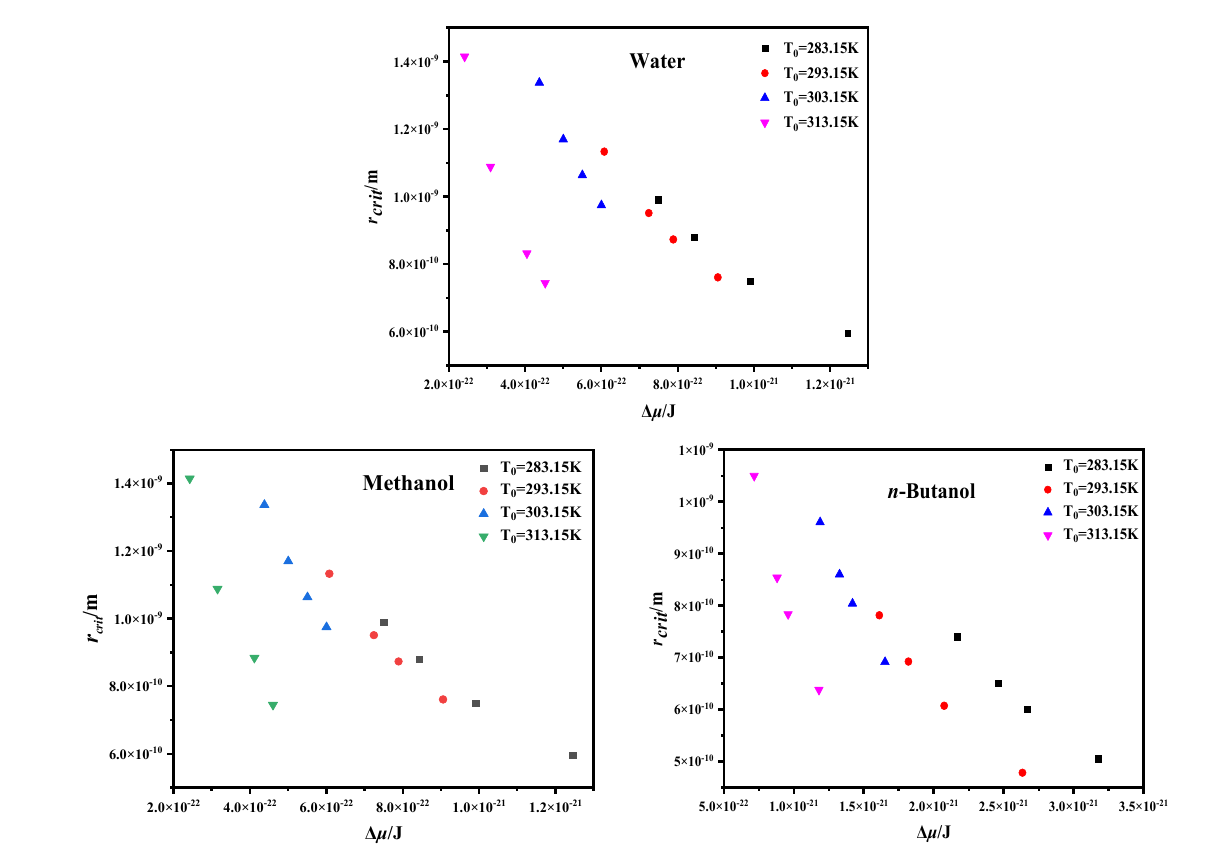
Figure 8. Relationships between driving force and critical nuclei size.